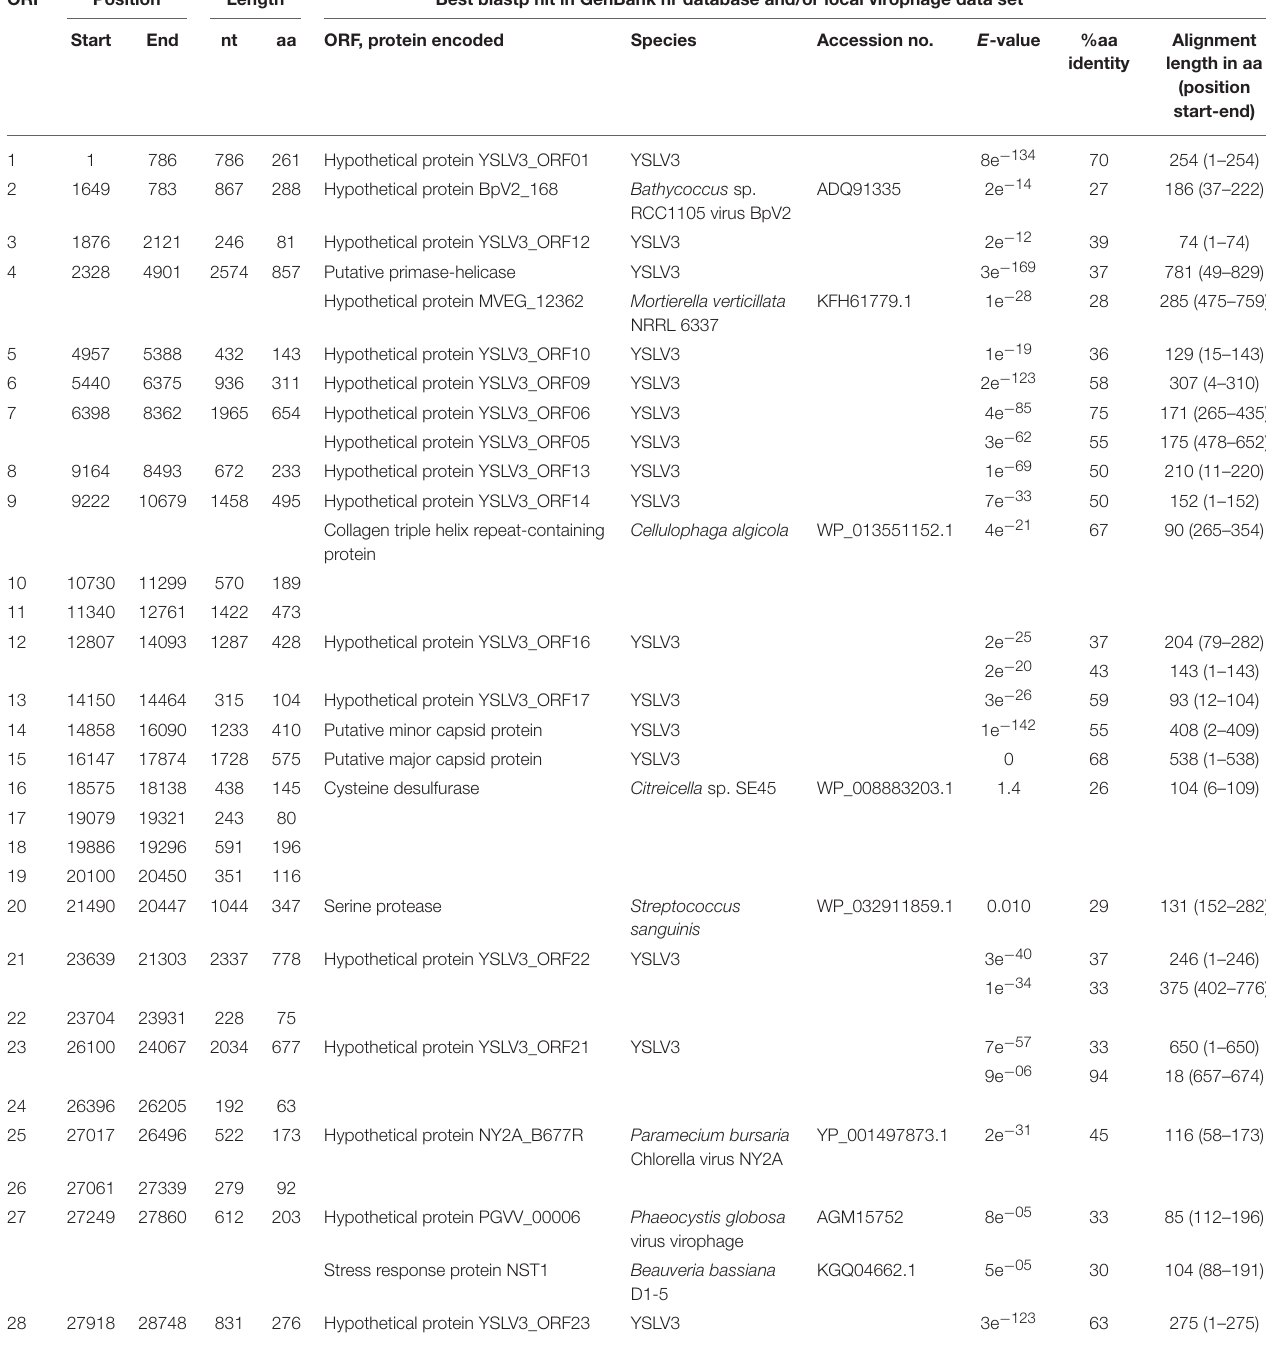
TABLE 8 | ORFs and their homologs predicted in